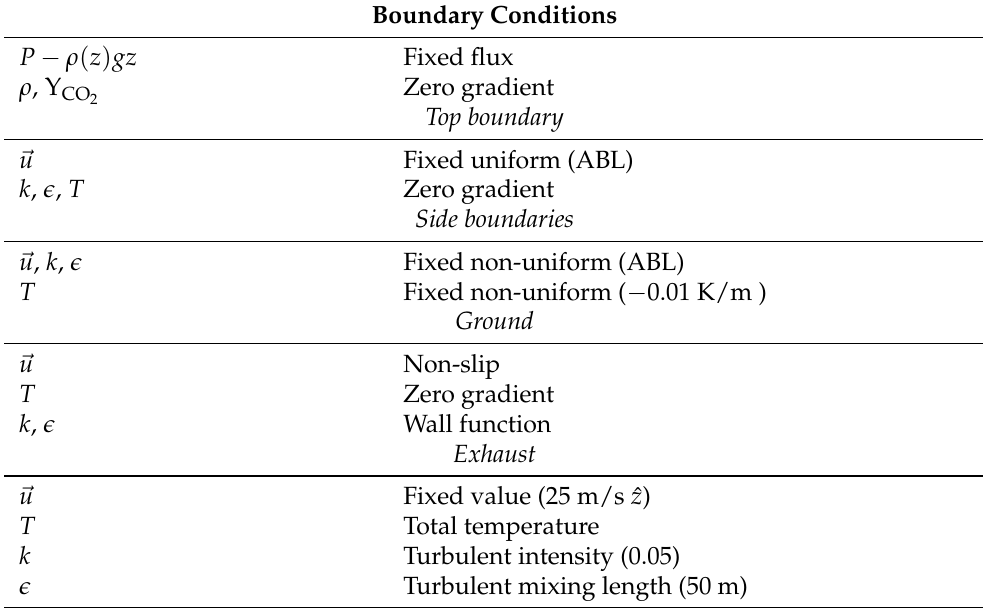
Table 2. Boundary conditions. All the boundary conditions used are detailed. The solver solves the quantity P − ρ gz instead of the total atmospheric pressure. Its boundary value is set up so that the gradient matches the velocity boundary